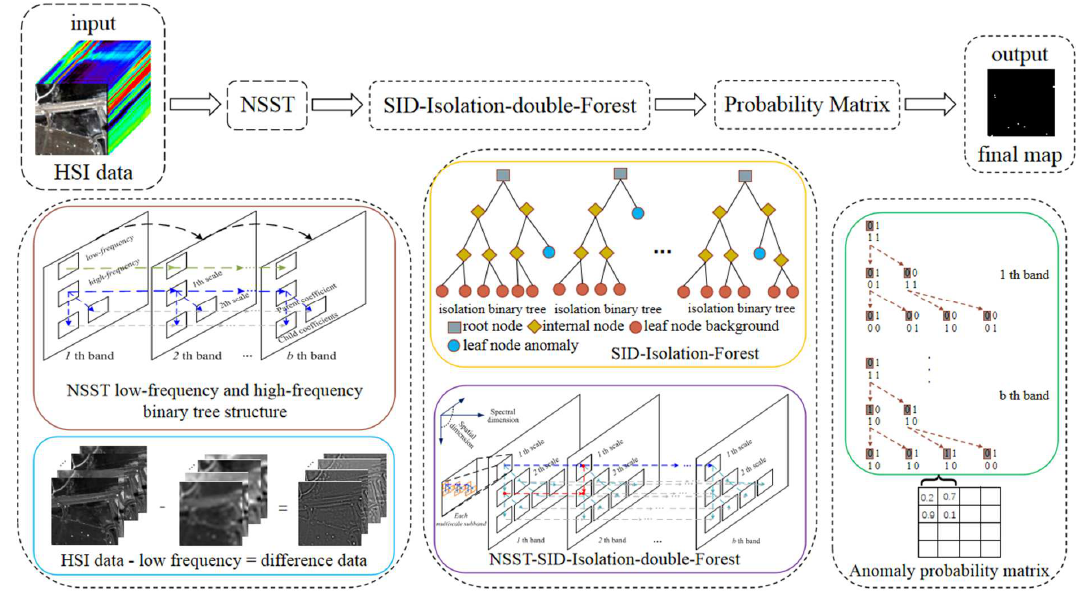
Figure 3. Flow chart of the proposed SI2FM-HSI-AD framework.